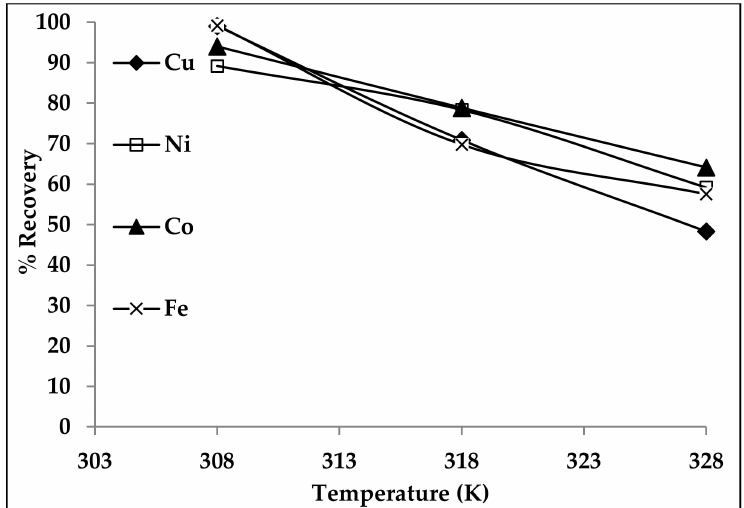
Figure 11. E ff ect of temperature (308–328 K) on recovery of Cu, Ni, Co, and Fe at 15% pulp density using 2 N citric acid in 15